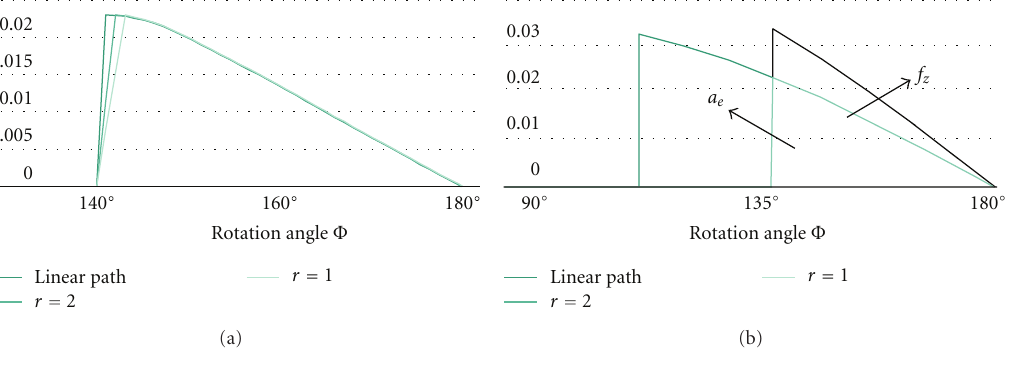
Figure 6: Sensitivity of the uncut chip thickness.